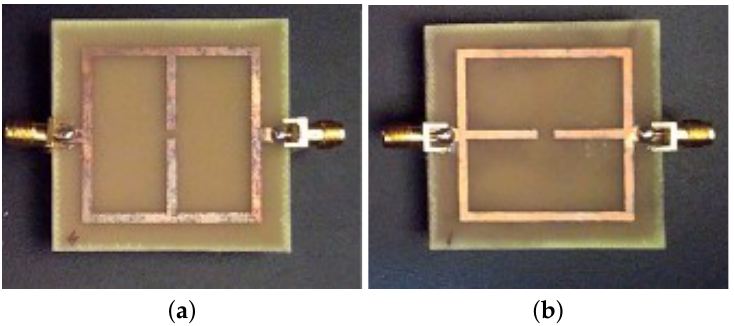
Figure 11. Photo of the first two prototypes reported in Figure 3 equipped with two SMA coaxial connectors: ( a ) stubs perpendicular and ( b ) parallel to the microstrip feeding line.